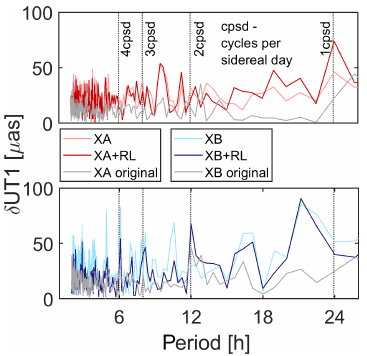
Figure 7. Amplitude spectra of δ UT1